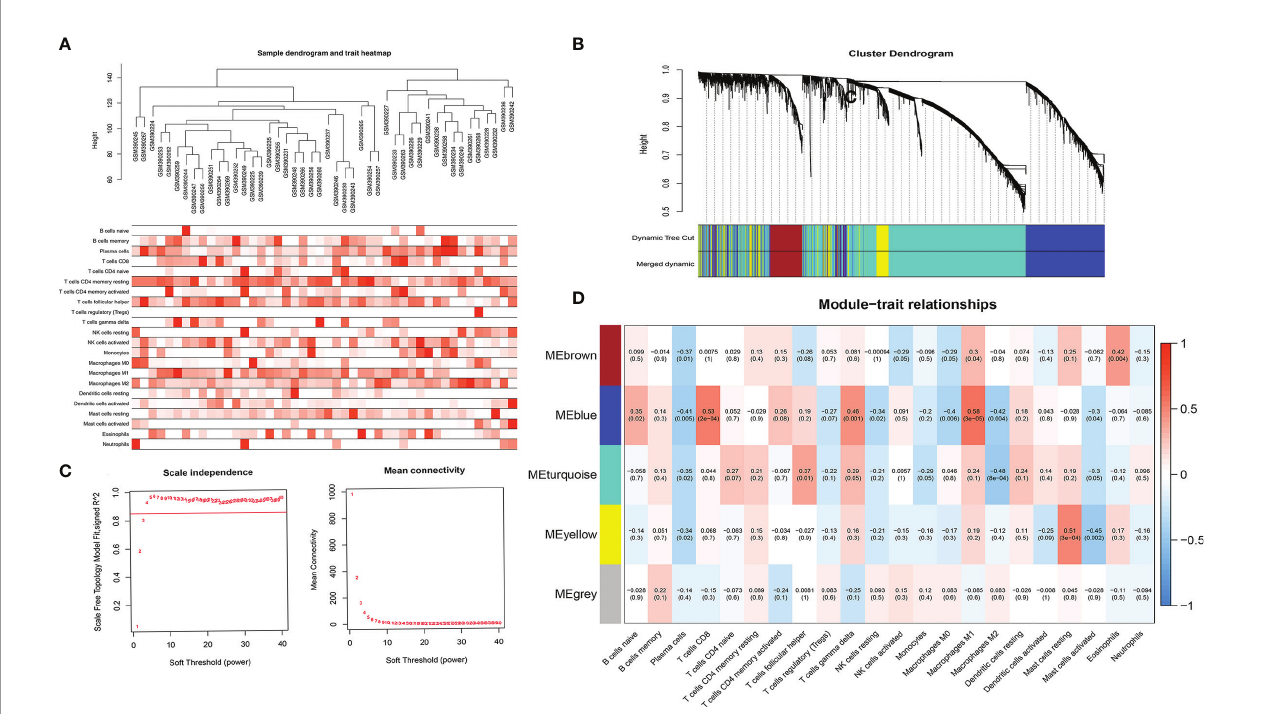
FIGURE 6 | (A) Sample tree map and characteristic heat map; (B) Clustering diagram of gene modules; (C) Soft threshold screening graph, which respectively represents the correlation between soft threshold and R2 and the relationship between soft threshold and average connectivity (the higher the correlation coef fi cient squared, namely R2, the closer the network is to the scale-free network distribution, generally not less than 0.8; (D) Correlation results between co-expressed gene modules and immune cell subtype